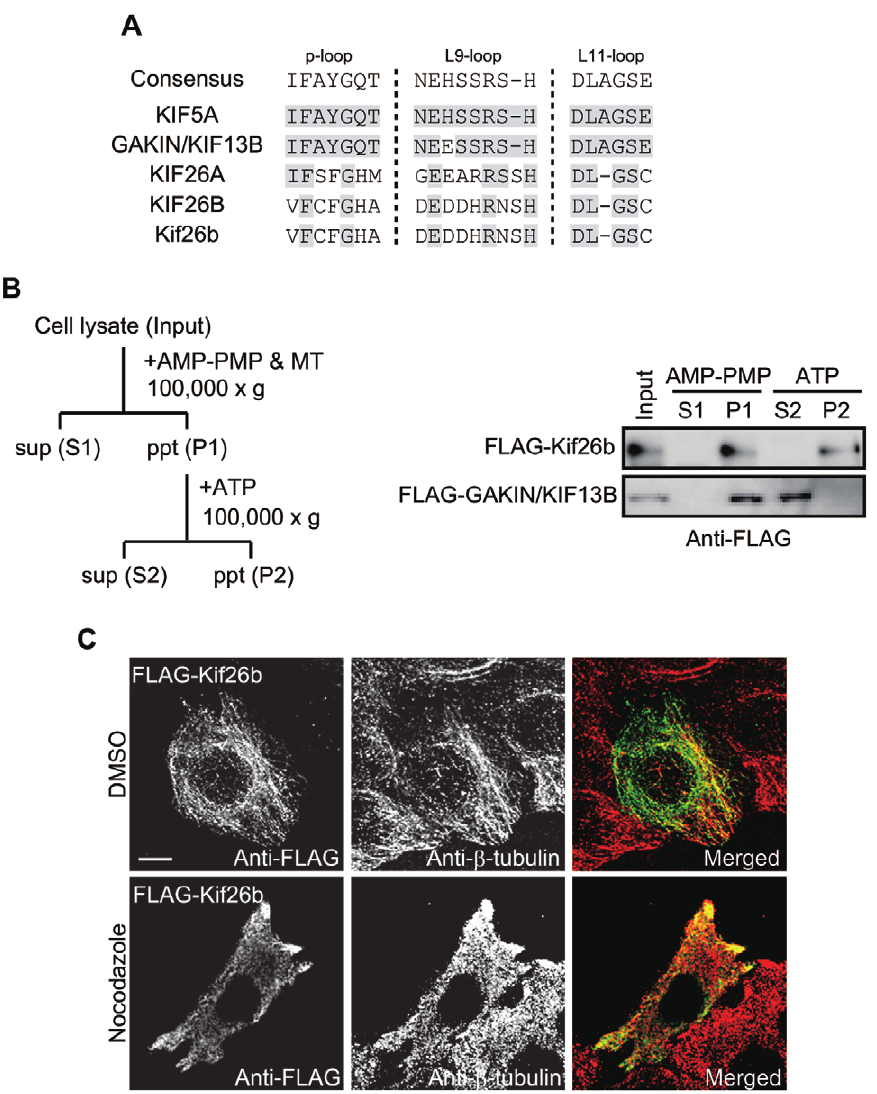
Figure 5. Kif26b is an unconventional kinesin. A. Alignment of the amino acid sequences of the motor domains of various KIFs. Human KIF5A, GAKIN/KIF13B, KIF26A, and KIF26B and mouse Kif26b are shown. Amino acids that correspond to the p-loop, L9-loop, and L11-loop consensus sequences are shown on a gray background. B. Schematic diagram of the microtubule-binding assay procedure (left panel). COS-7 cells were transfected with FLAG-Kif26b- or FLAG-GAKIN/KIF13B-expressing plasmids. At 48 h after post-transfection, the microtubule-binding assay was performed on the cell lysates and the precipitates were analyzed by immunoblotting with anti-FLAG antibody (right panel). C. HeLa cells stably expressing FLAG-Kif26b were treated for 1 h with DMSO or nocodazole (5 m M). The cells were then fixed and stained with anti-FLAG (green) and anti- b -tubulin (red) antibodies. Scale bar=10 m m.